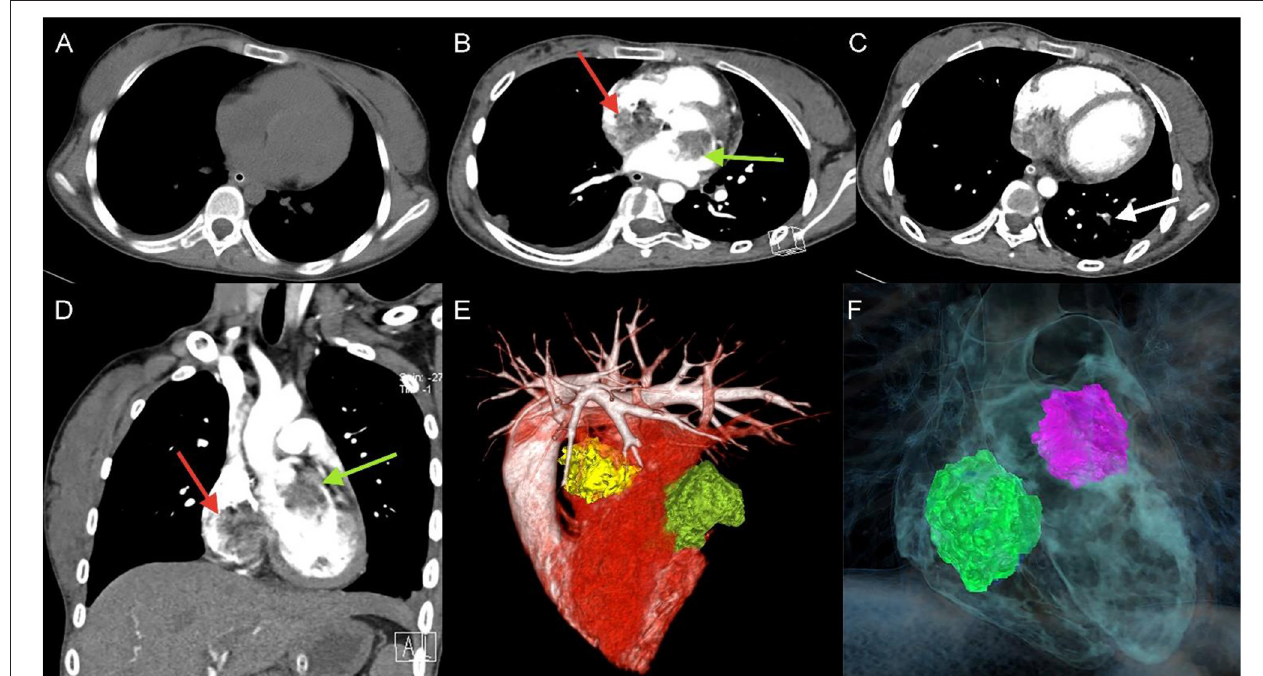
FIGURE 1 | Unenhanced thoracic CT (A) , axial and coronal views of Computed tomography pulmonary angiography (CTPA) detected filling defects in right atrium (red arrow), left atrium (green arrow) (B,D) , and left lower pulmonary basilar artery (white arrow) (C) , three-dimensional reconstruction of heart (E) and (F) corresponding schematic illustration demonstrating the biatrial